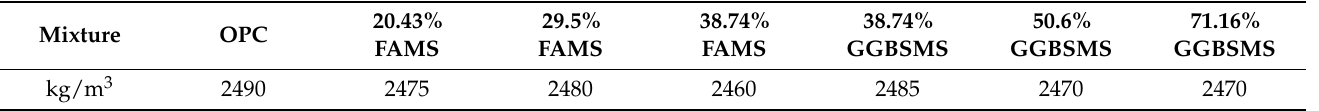
Table 6. Fresh density for SCC